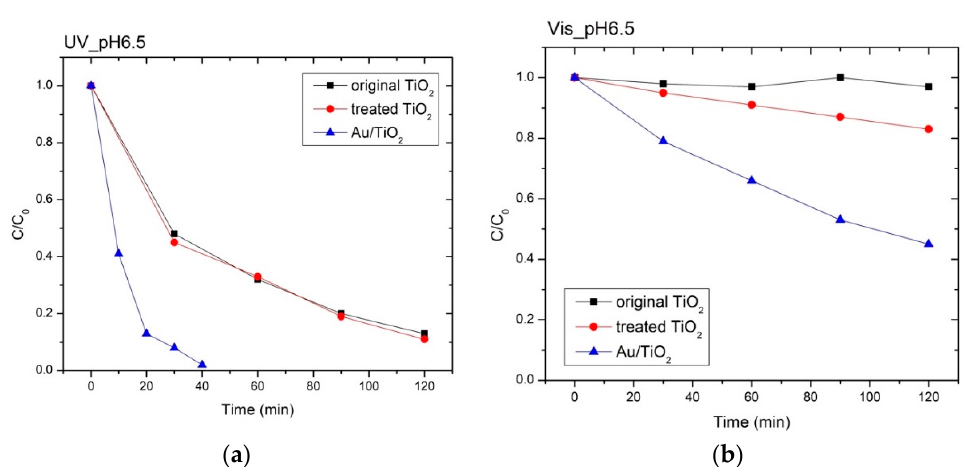
Figure 5. Comparison of the photocatalytic degradation of MB with different photocatalysts under ( a ) UV and ( b ) visible light irradiation at a pH value of 6.5.